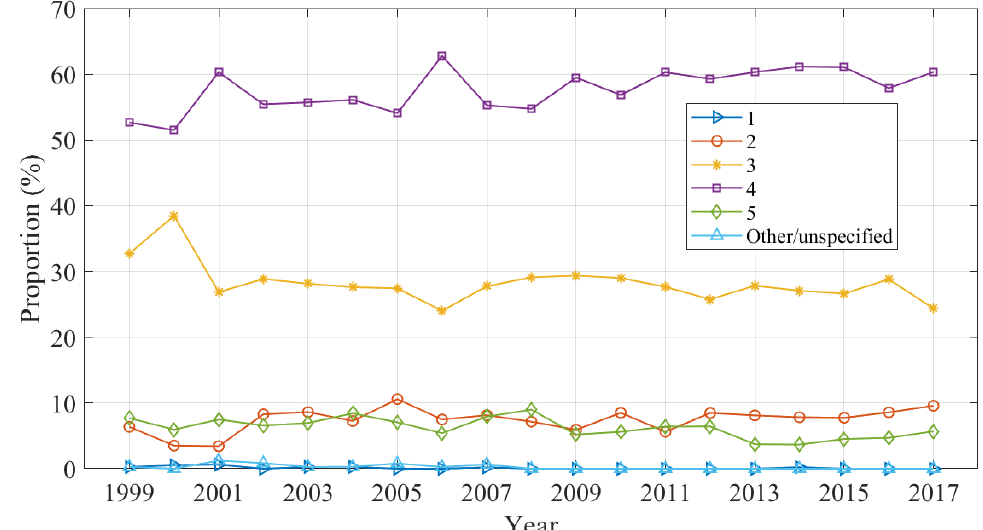
Figure 6. Proportion of injuries by severity.